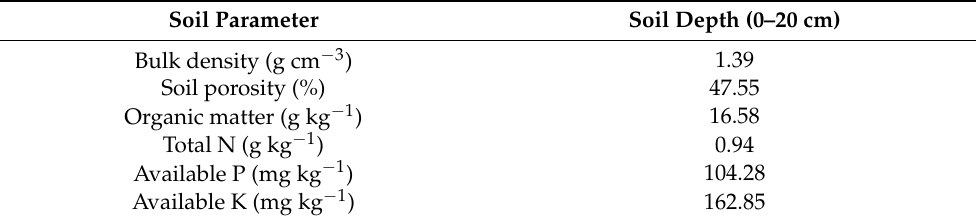
Table 1. Selected soil properties at the 0–20 cm soil